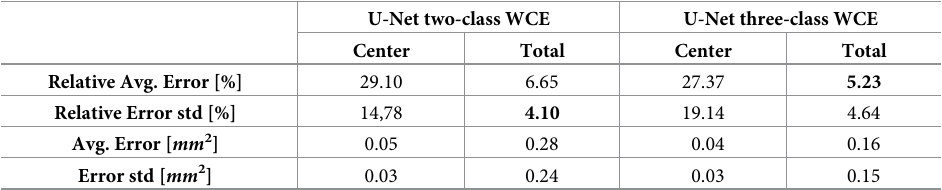
Table 6. Average error and error standard deviation between manual and automatic measurements of the total eyespot and center areas. Relative errors and errors in mm 2 are